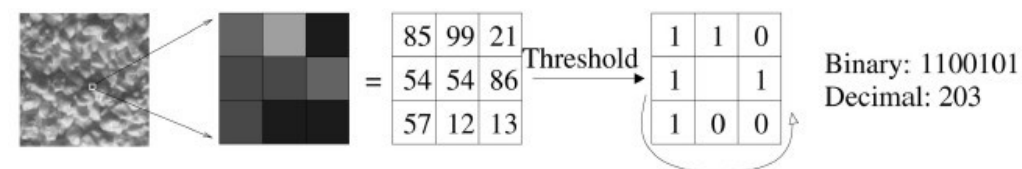
Figure 1. The processing of LBP operators.